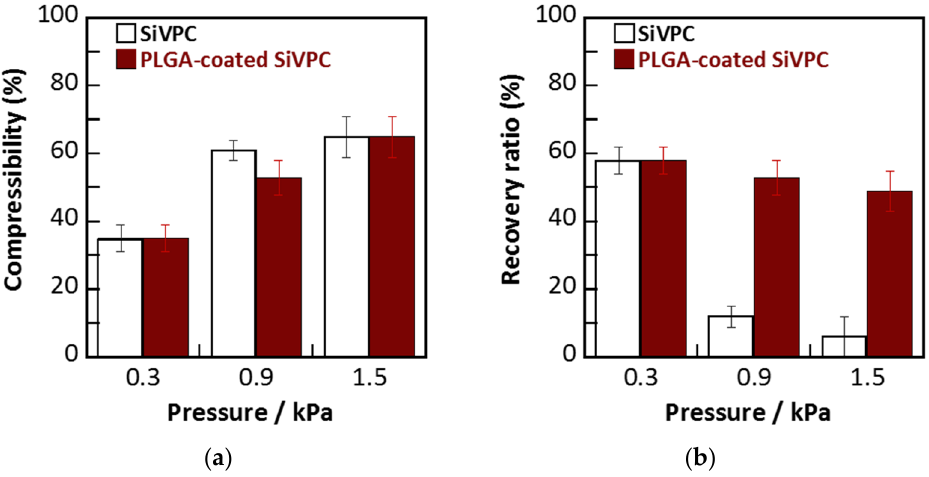
Figure 3. ( a ) Compressibility of cotton ‐ wool ‐ like SiVPC and PLGA ‐ coated SiVPC; ( b ) recovery ratios of the materials. The error bar shows the standard deviation ( n =